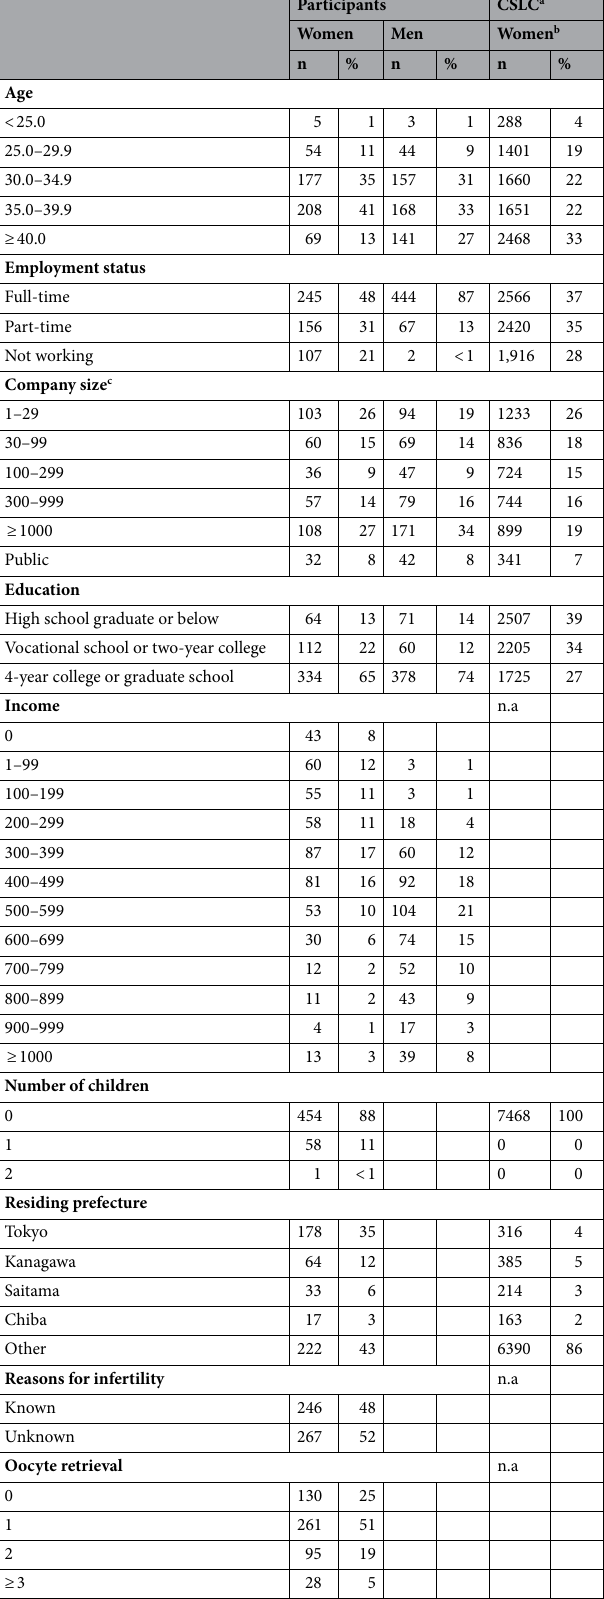
Table 1. Socio-demographic profile of participants (n = 513), compared with national data (n = 7468). n.a . not avaiable. a Year 2016 Comprehensive Survey of Living Conditions (national data). b Married women between the ages of 20 and 45 with no children. c Among those who are